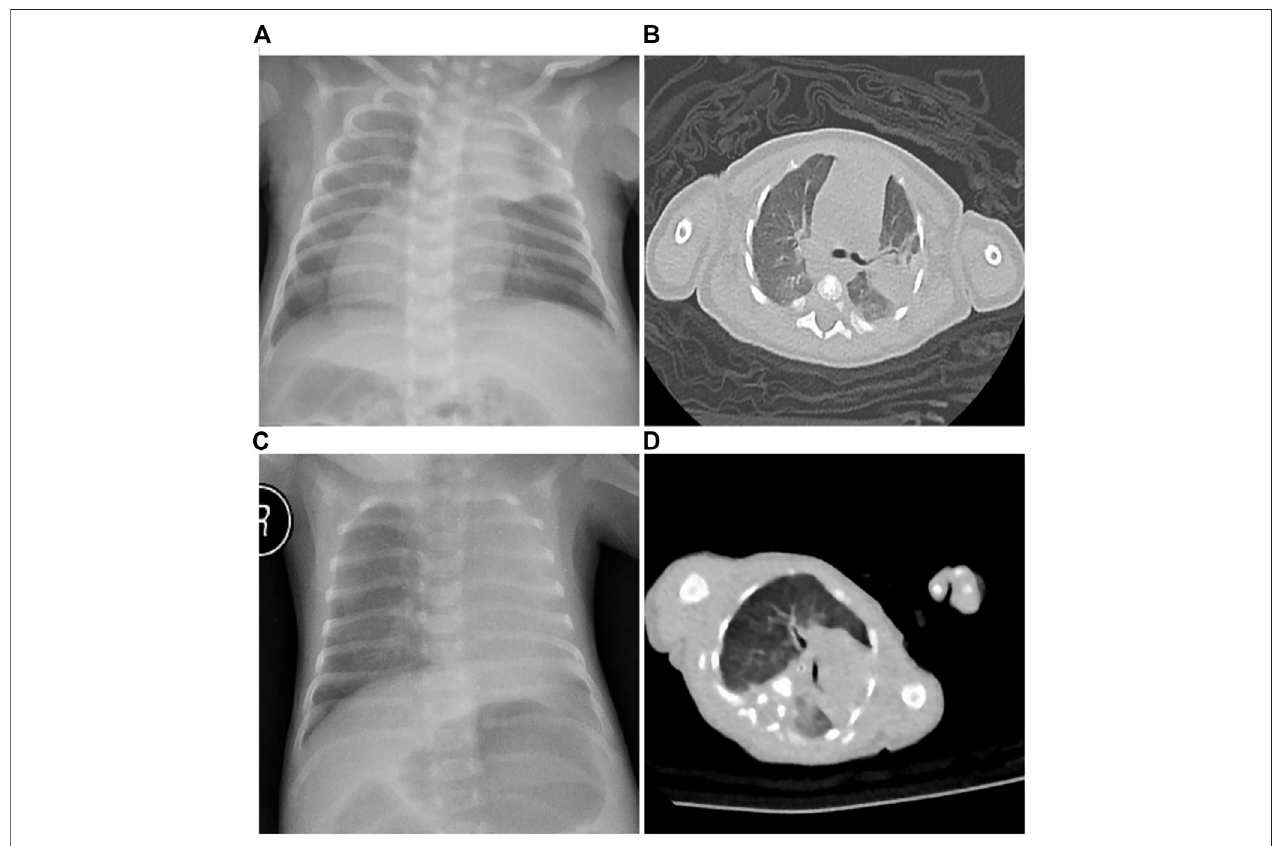
FIGURE 1 | Radiological examination of the twins. (A) Twin A chest X-ray showed consolidation and atelectasis in the left upper lung, heart inversus and right-sided placement of the stomach bubble. (B) Twin A chest CT revealed bilateral lung infection with consolidation in the left upper lobe and mirror-image dextrocardia. (C) Twin B chest X-ray showed atelectasis in the left upper lung and normal cardiac and stomach placement. (D) Twin B chest CT revealed atelectasis in the left upper lung.